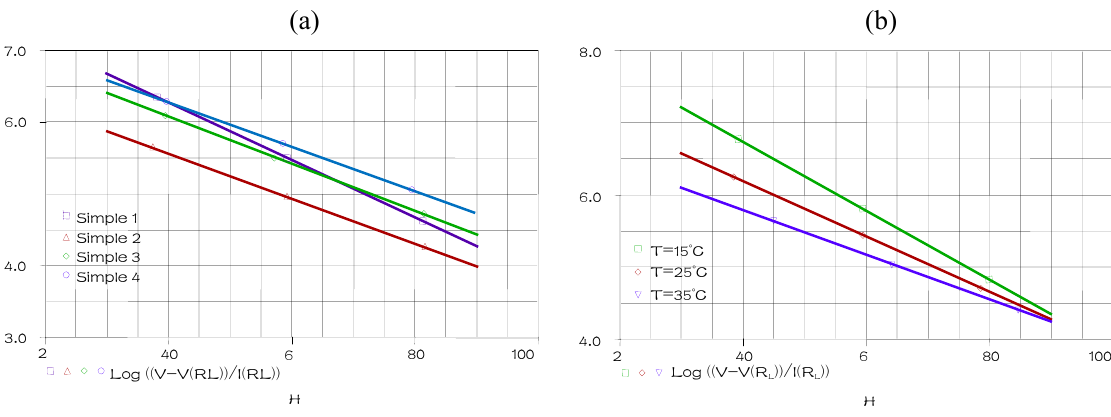
Figure 6. (a) SM output for a parametric SWEEP analysis for samples 1–4 at fixed temperature and frequency 25 °C and 1 KHz respectively (b) SM output for a parametric SWEEP analysis for the sample 1 at fixed frequency 1KHz, for the temperatures 15, 25 and 35